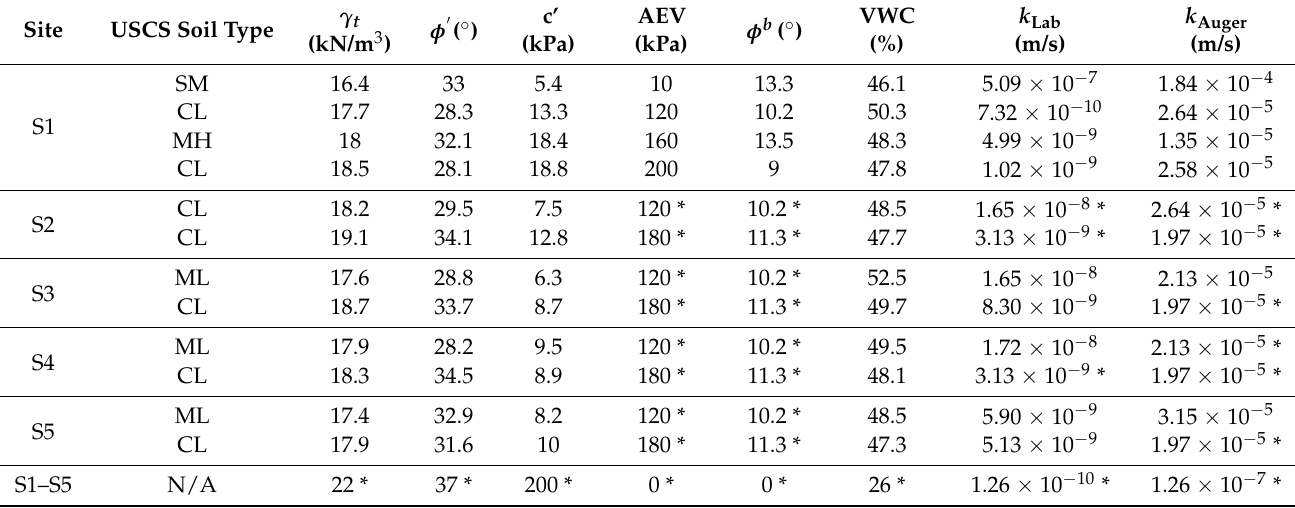
Table 2. Soil properties for seepage and riverbank stability modeling.